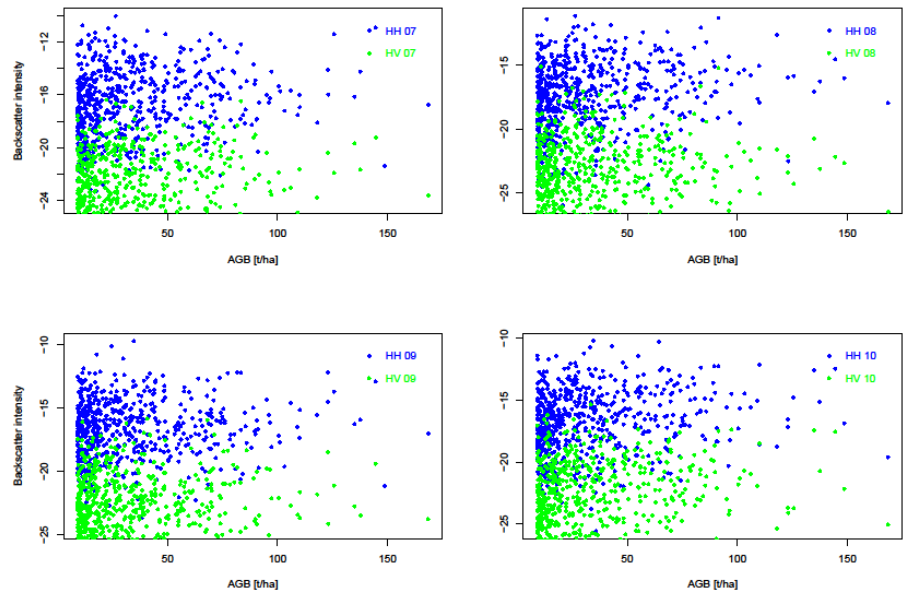
Figure 11. Correlation between Synthetic Aperture Radar (SAR) backscatter intensities (HH and HV) and TLS-derived reference aboveground biomass for the years 2007–2010. Forests 2016 , 7 , 294